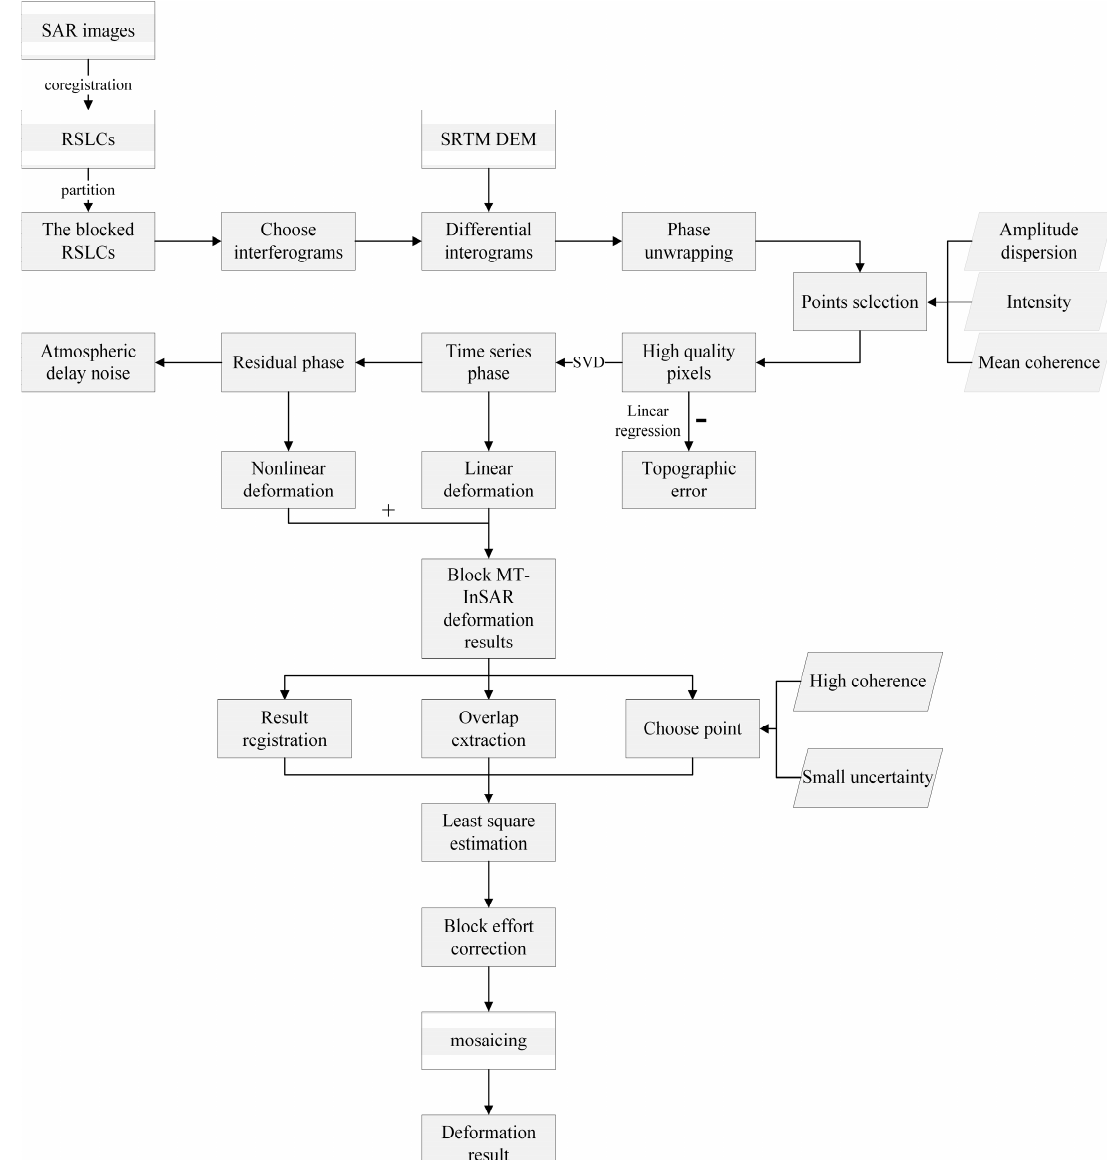
Figure A1. The detailed flowchart of the proposed method.